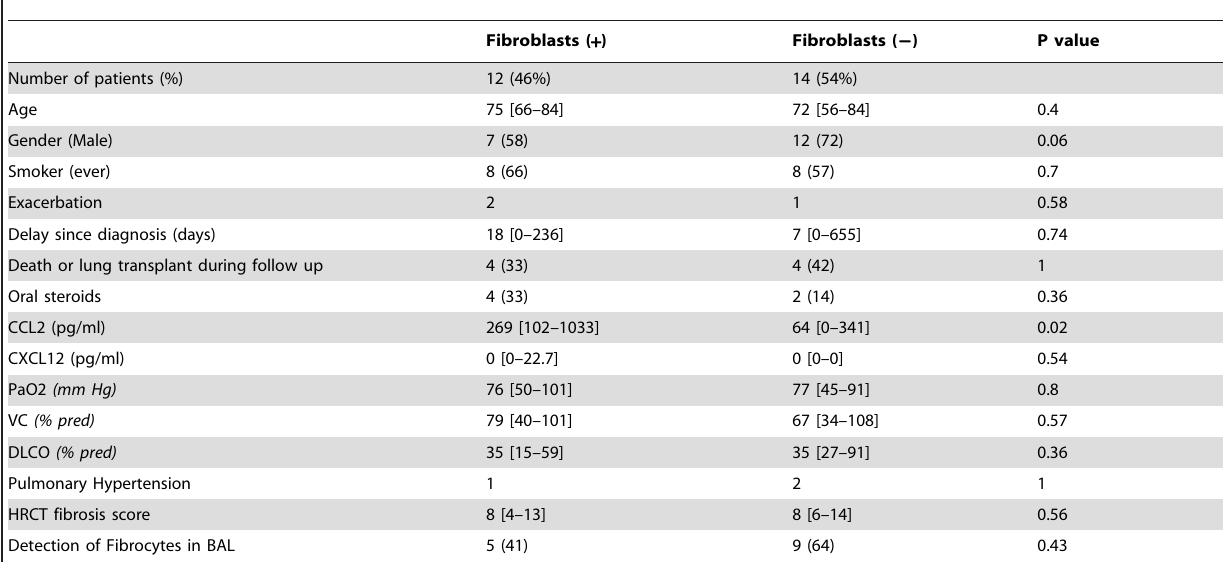
Table 4. Clinical and functional characteristics of the IPF patients with positive or negative cultures of